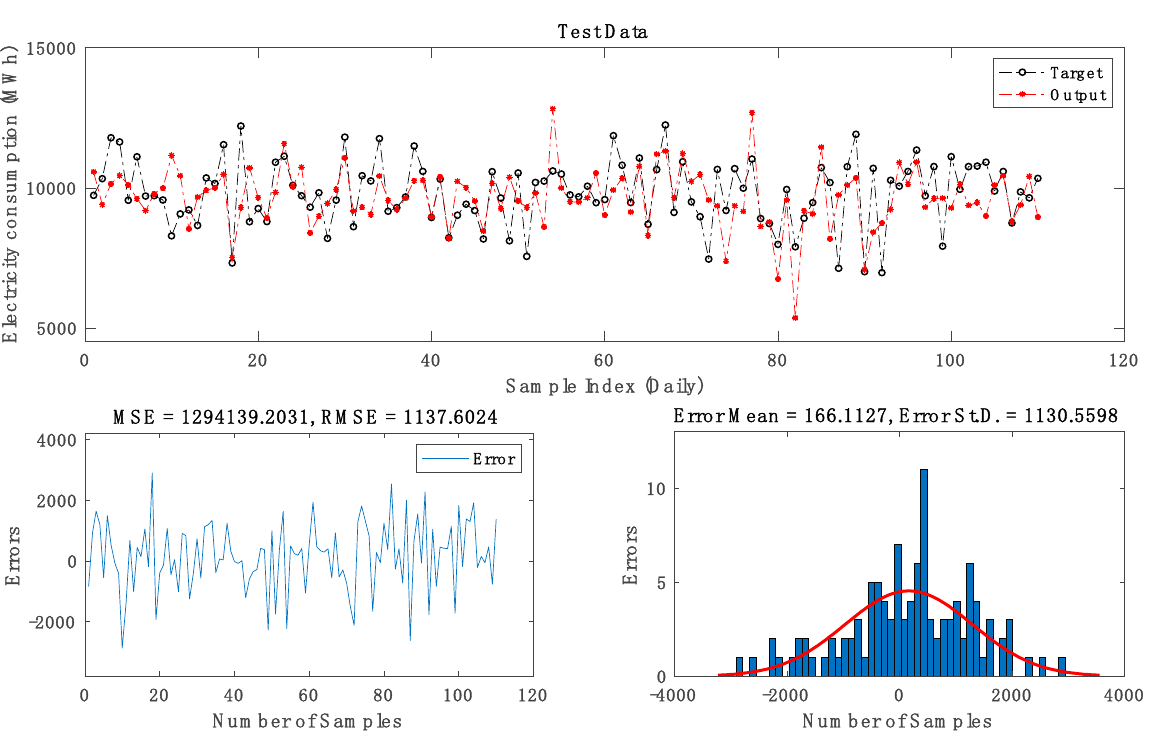
Figure 7. Optimal ANFIS-SC5 sub-model.